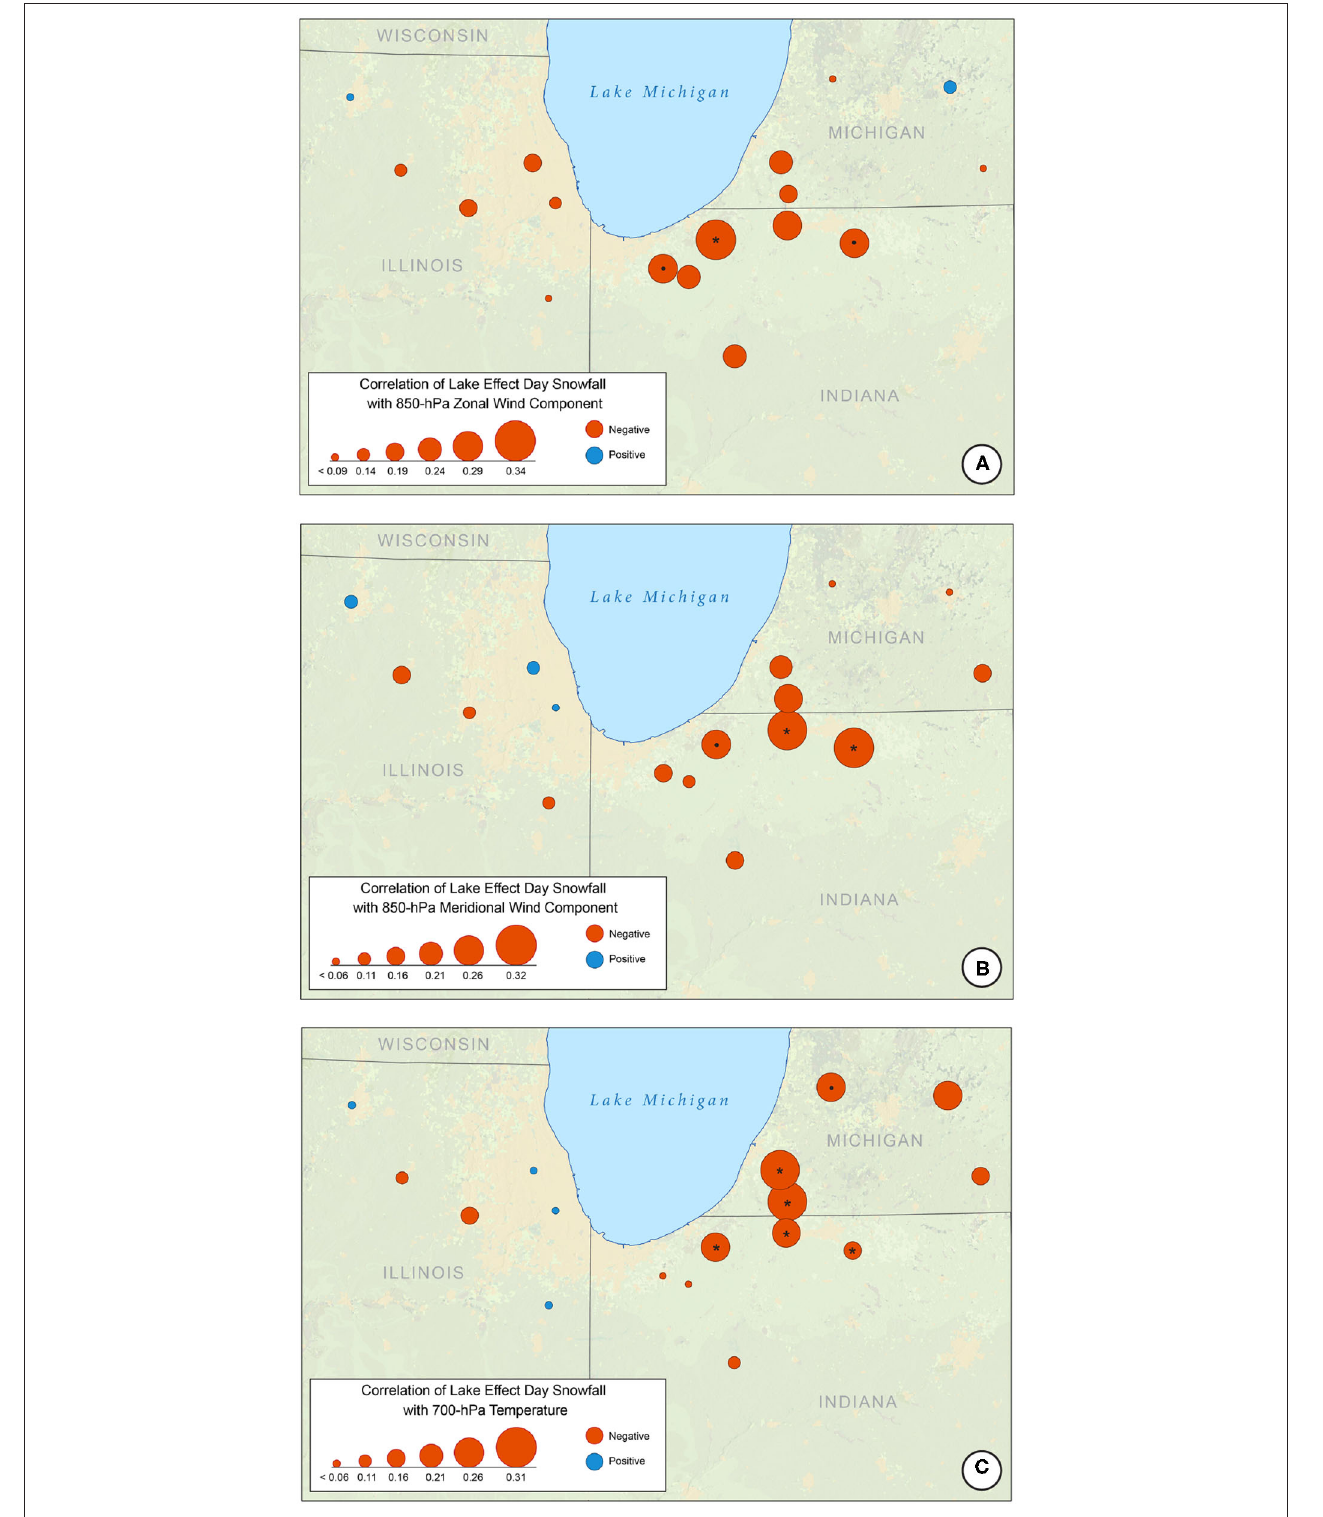
FIGURE 7 | Map of correlation coefficients of snowfall and variables from the upstream sounding at Green Bay, WI, during lake-effect snow days. Sounding variables include the 850-hPa zonal (u; A ) and meridional (v; B ) wind components and 700-hPa temperature (C) . A bootstrap approach was used to infer the significance of correlations at the 95 and 90% confidence thresholds,